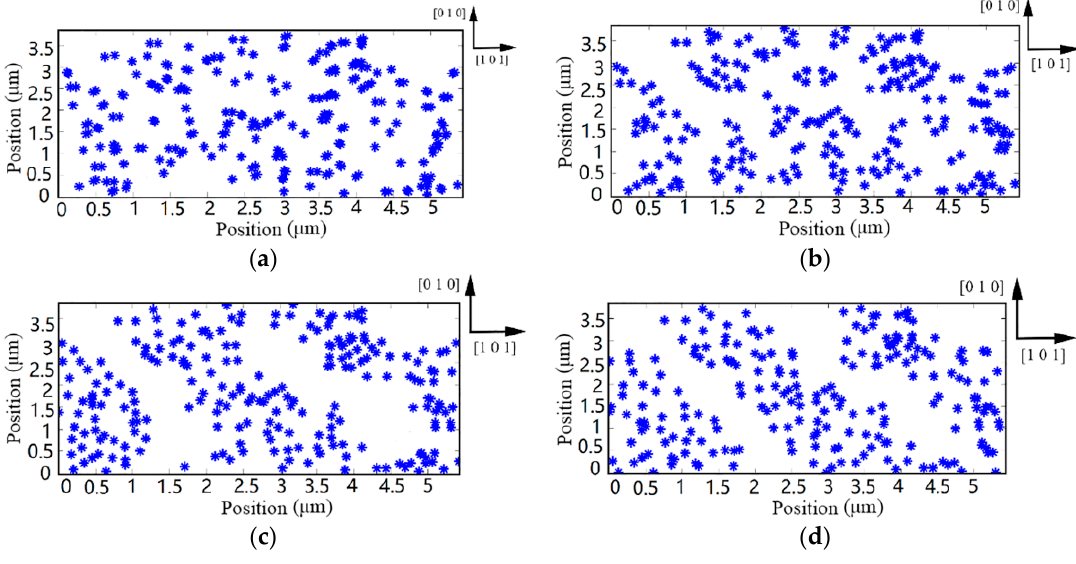
Figure 10. Dislocation patterns of monocrystalline silicon during continuous irregular cutting process. ( a ) Dislocation at 200 ns; ( b ) dislocation at 800 ns; ( c ) dislocation at 1400 ns; ( d ) dislocation at 2000